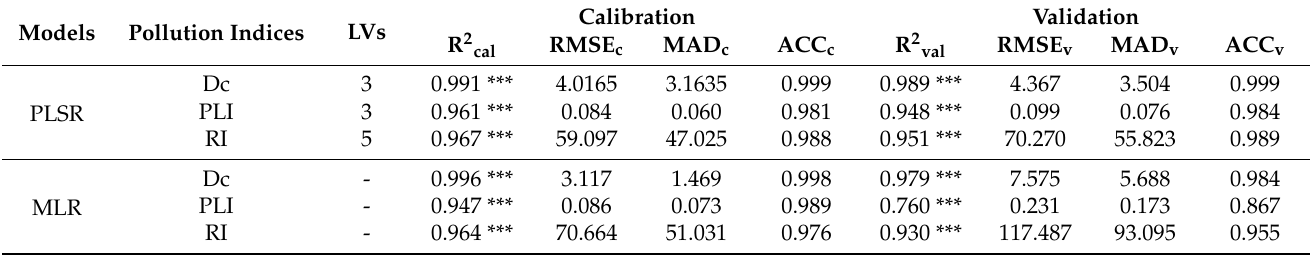
Table 9. Results of calibration (R 2 cal , RMSE C , MAD c , and Acc c ), and ten-fold cross-validation (R 2 val , RMSE v , MAD v , and Acc v ): PLSR and multiple linear regression MLR models of the relationships between several heavy metals and three pollution load indices (PLI, RI and Dc). ***: p <